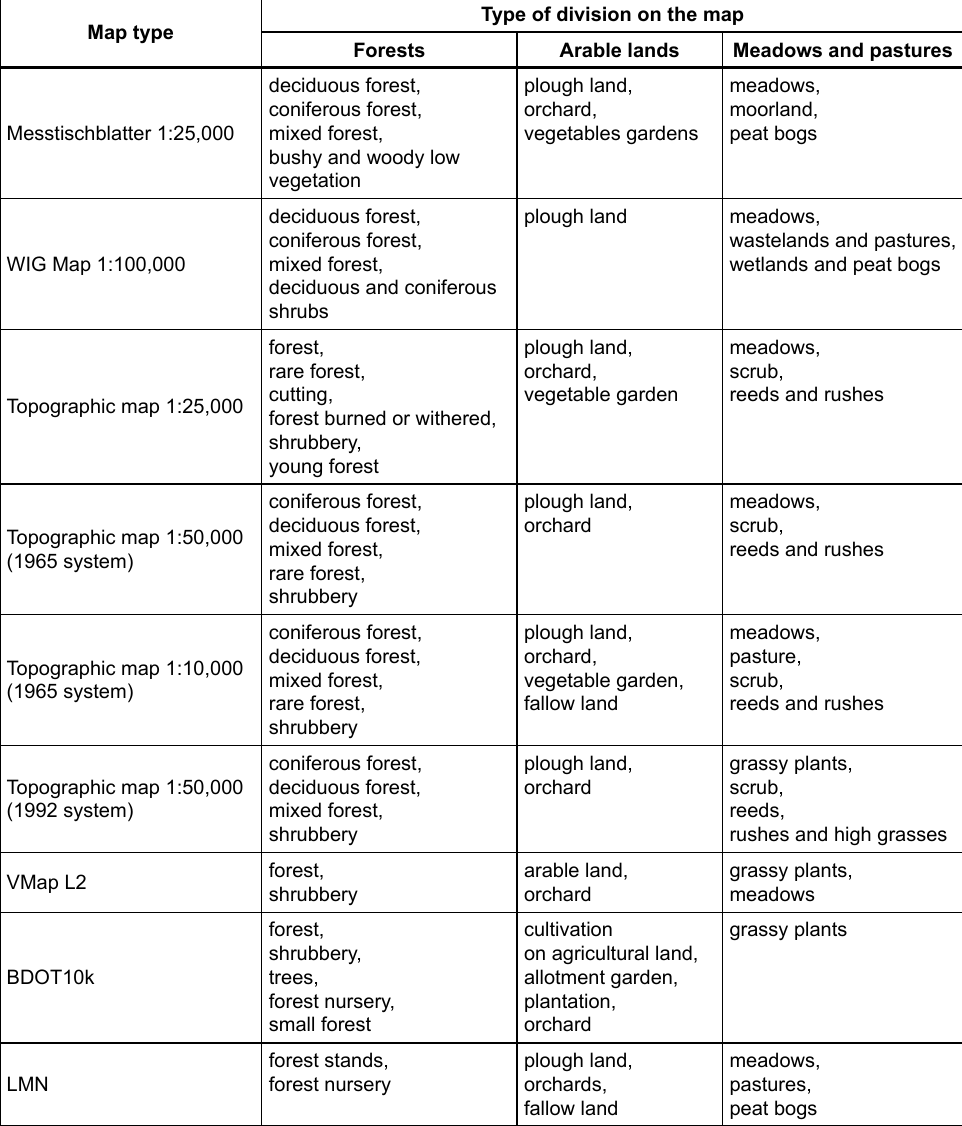
Type of division on the